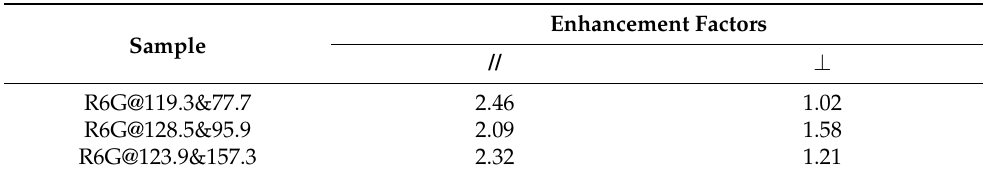
Table 1. Enhancement Factors of R6G@Dimers under Longitudinally and Transversely Polarized Laser